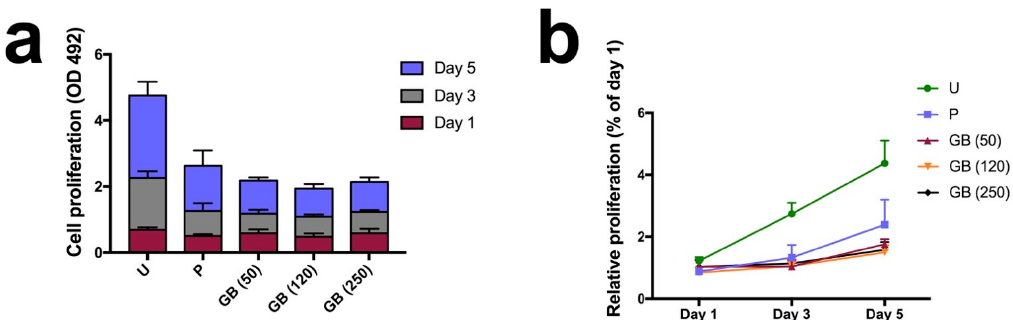
Figure 5. Cell proliferation on the sample surfaces at different time points assessed via CCK-8 assay. ( a ) cell proliferation (OD value at 492 nm wavelength); ( b ) relative proliferation on the 3rd and 5th day, normalized by the values on the 1st day. U: untreated group; P: polished group; GB (50): 50 µm grit-blasted group; GB (120): 120 µm grit-blasted group; GB (250): 250 µm grit-blasted group.